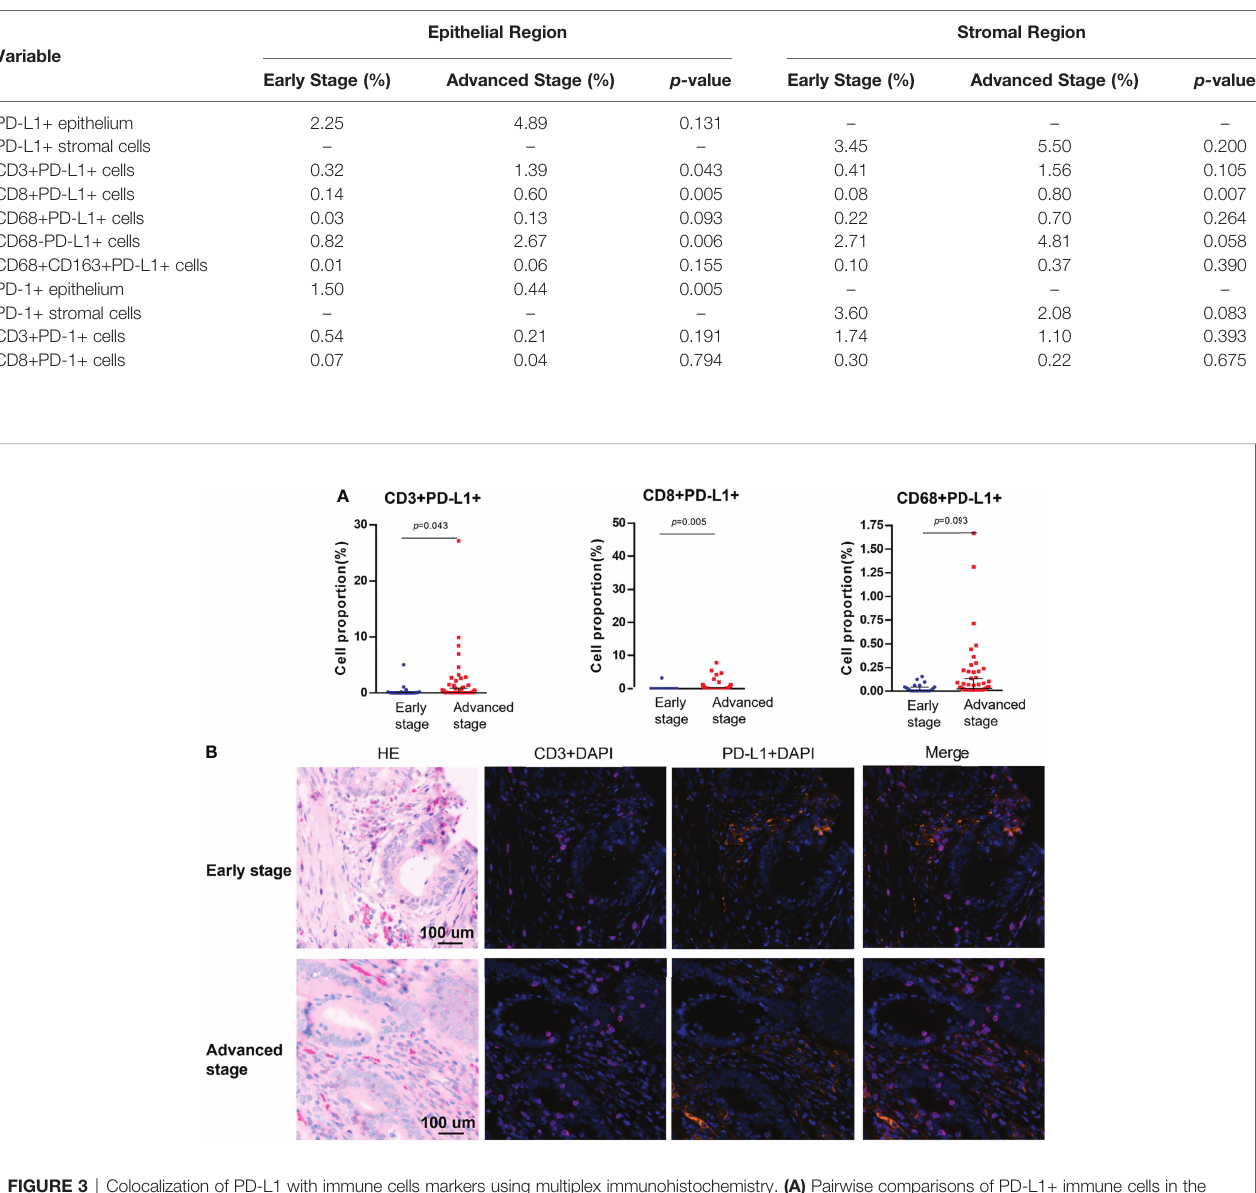
( Figure 4A ). The same results were obtained for the DFS survival curves (HR = 3.7, 95% CI = 1.12 – 12.01, log rank p = 0.010) ( Figure 4B ). However, the other immune cell phenotype had no prognostic value in early-stage dMMR (data not shown).